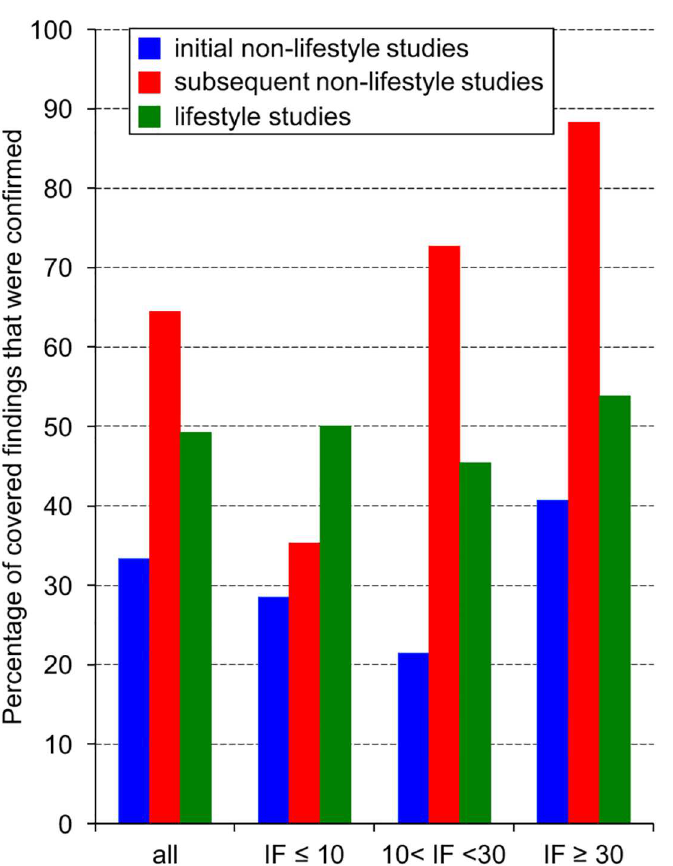
Fig 2. Replication validity of primary articles reported by newspapers. The figure shows the percentage of primary articles echoedby newspapers whose main finding was consistent with the correspondingmeta- analysis. We considered here the same three categoriesas in Fig 1: primary articles of the lifestyle category and initial or subsequent non-lifestyle studies. Raw data are given in SupportingInformation (S2